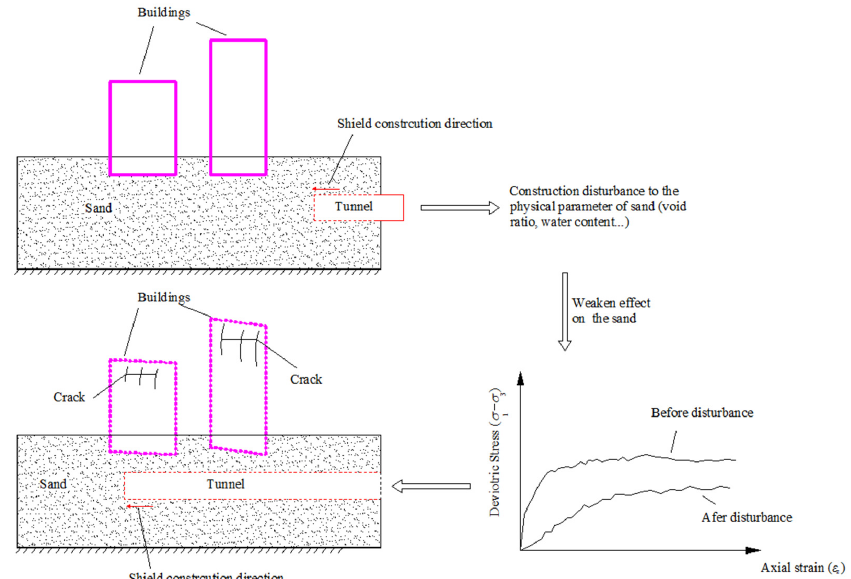
Figure 1. Shield construction disturbance to the mechanical properties of coastal sand.